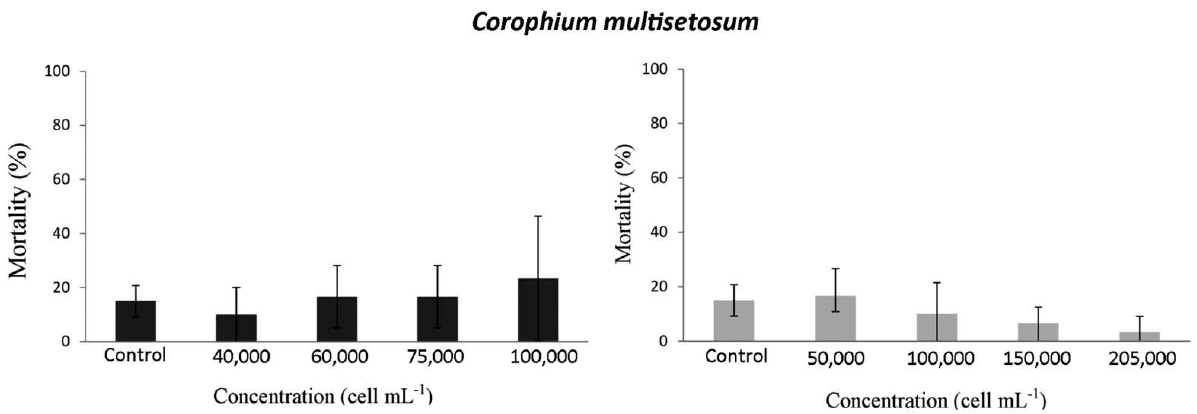
Fig. 5. – Mortality after 72 h of Corophium multisetosum exposed to culture of Alexandrium minutum (left) and Prymnesium parvum (right). No significant differences in mortality between control and samples were